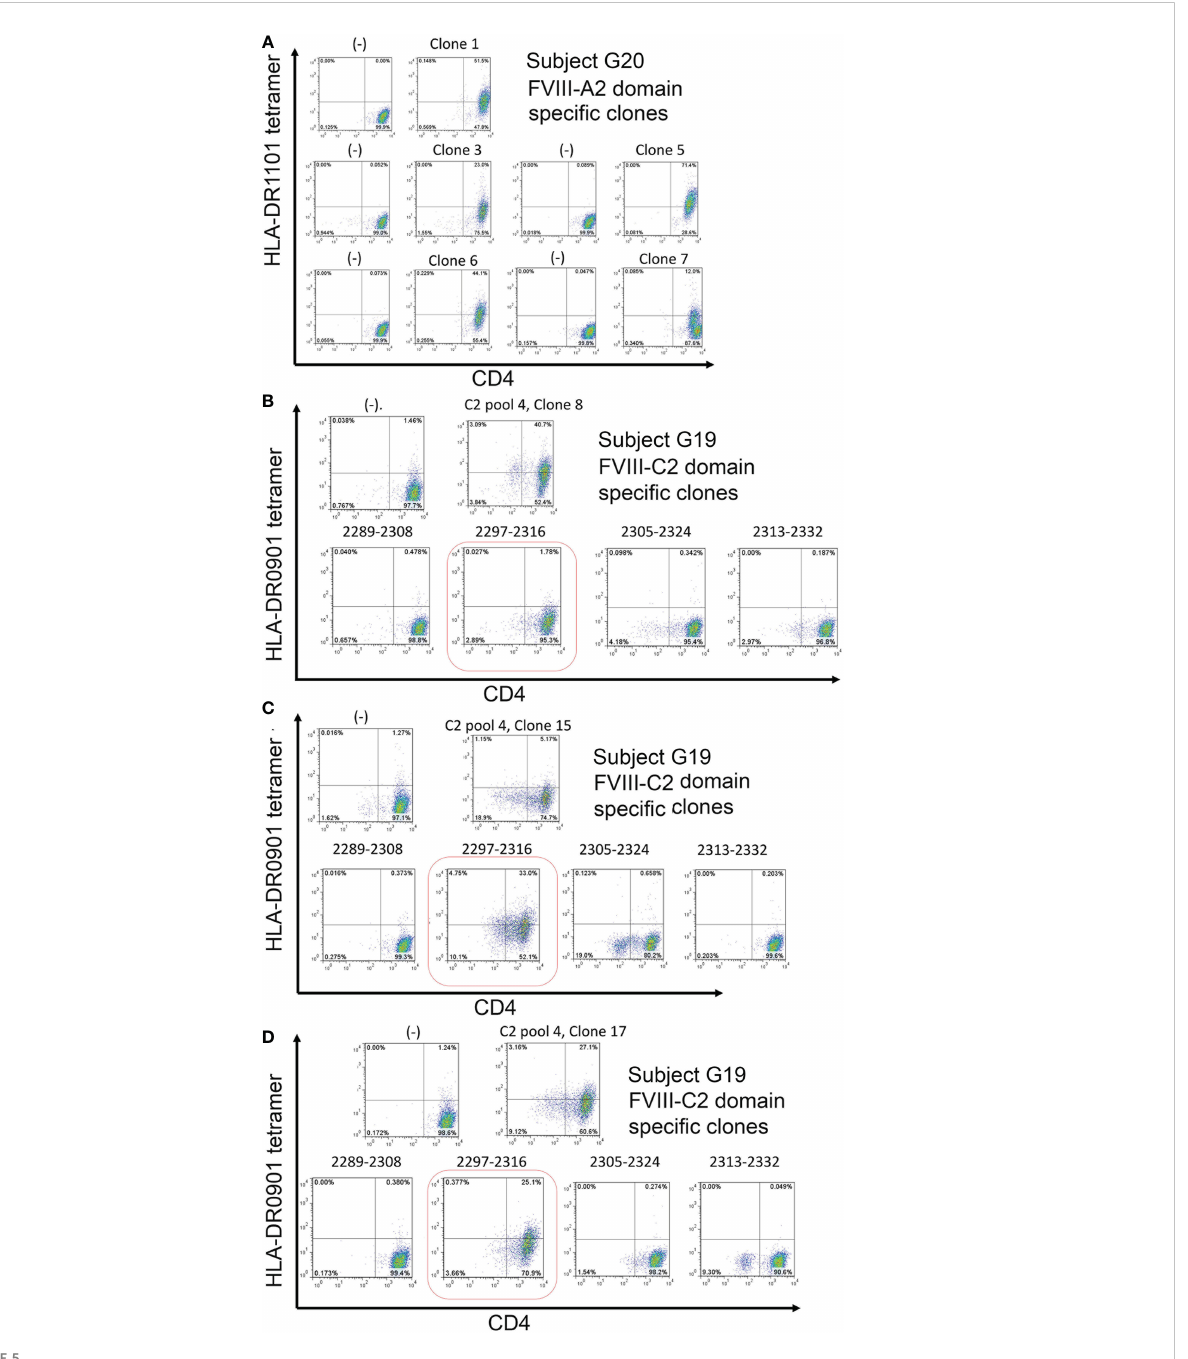
FIGURE 5 Tetramer staining identi fi es CD4 + T-cell clones restricted to FVIII A2 and C2 domain peptides. A. CD4 + T-cell clones restricted to one or more epitopes in the FVIII A2 domain were isolated from inhibitor subject G20 (Int22Inv, HLA-DRB1*0301, 1101 ) PBMCs by staining his CD4 + T cells with DR1101 tetramers loaded with A2 peptide pool #6 (four 20-mer peptides spanning FVIII residues 565-616). The tetramer-hi cells were then single-cell sorted, expanded in culture, and the expanded clones were stained with the same tetramer, following standard protocols in our laboratory (29). All fi ve clones showed high-avidity tetramer binding . B, C, D. CD4 + T-cell clones recognizing pooled and individual peptides corresponding to the FVIII C2 domain were isolated from inhibitor subject G19 (Int22Inv, HLA-DRB1*0302, 0901 ) following a similar protocol. Clones recognizing C2 pool 4 peptides (spanning FVIII residues 2238-2332) were isolated. Decoding of this response using DR0901 peptides loaded with the individual peptides comprising this pool identi fi ed FVIII 2297-2316 as the immunodominant epitope. Negative controls: staining using the same HLA-DR tetramers loaded with irrelevant (tetanus) peptides did not produce tetramer-hi signals, indicating that these tetramers did not bind nonspeci fi cally to CD4 + T